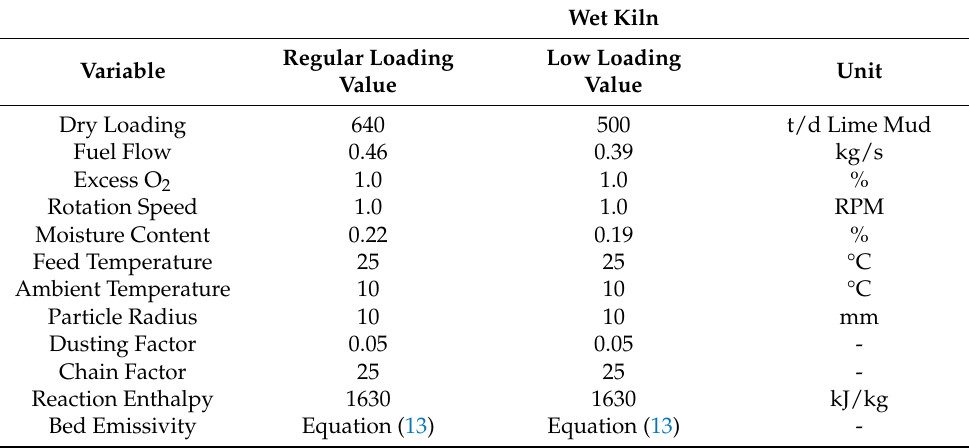
Table 5. Wet kiln baseline